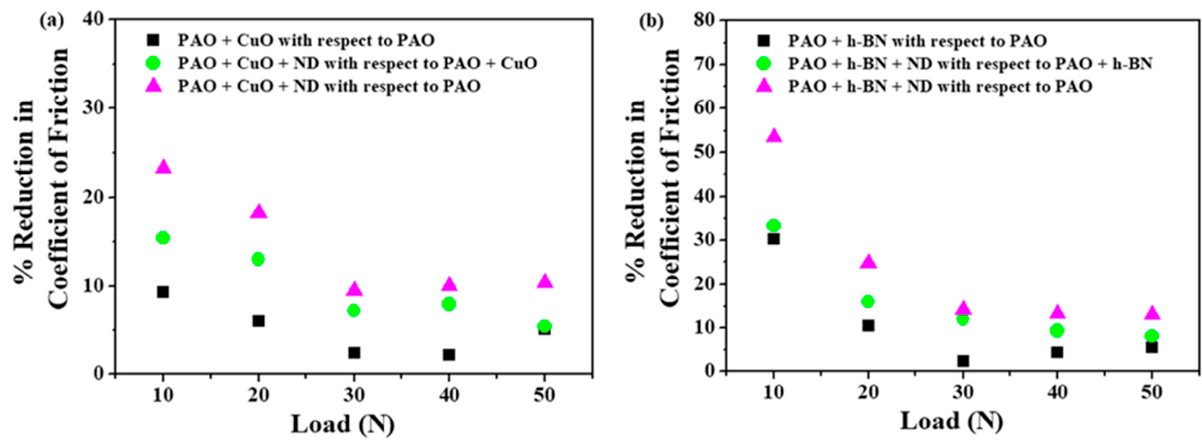
Figure 17. Percentage reduction in the average values of COF of steel–aluminium tribopairs under: ( a ) PAO + CuO primary additive/+ ND secondary additive nanolubricants and ( b ) PAO + h-BN primary additive/+ ND secondary additive nanolubricants.